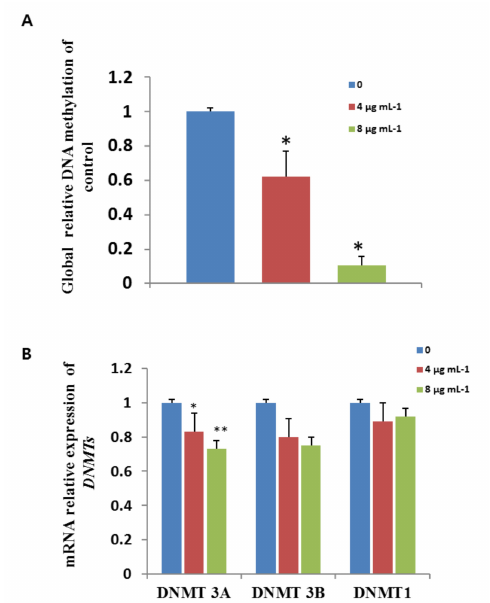
Figure 11. Effects of GO-AgNPs on global DNA methylation and gene expression levels. Caprine fetal fibroblast cells (CFFCs) were treated with 0, 4, and 8 µ g/mL of GO-AgNPs for 24 h. Relative global DNA methylation ( A ) and mRNA levels of DNMTs ( B ) were determined. Values are presented as the mean ± SD of four independent experiments (* p < 0.05; ** p <